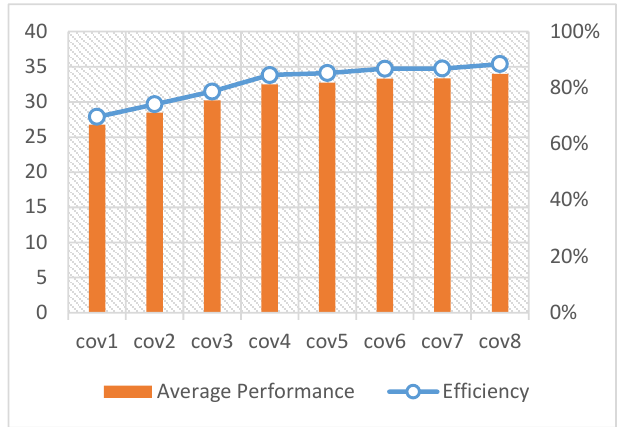
Figure 15. Accelerator computing performance and efficiency.